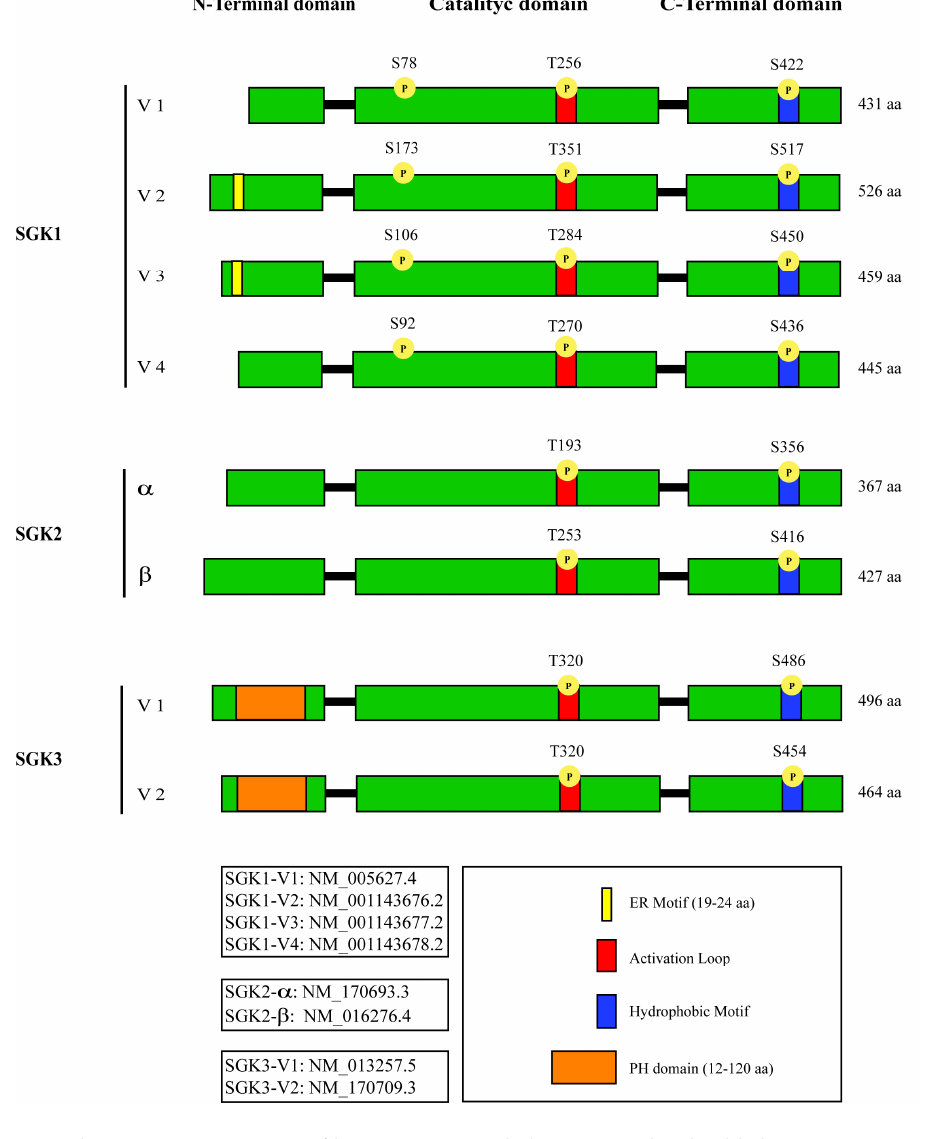
Figure 1. Schematic representation of known serum and glucocorticoid-inducible kinases SGK1, SGK2, and SGK3 splicing variants.